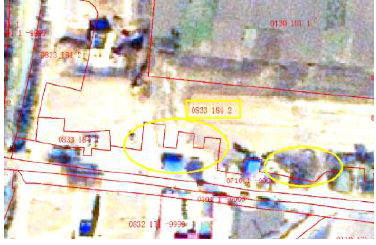
Figure 1. Position accuracy